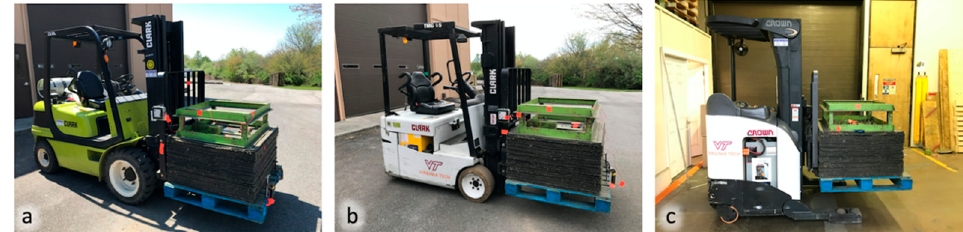
Figure 1. Representative pictures of the investigated forklifts: ( a ) gas-powered forklift, ( b ) electric- powered forklift, ( c ) reach truck.